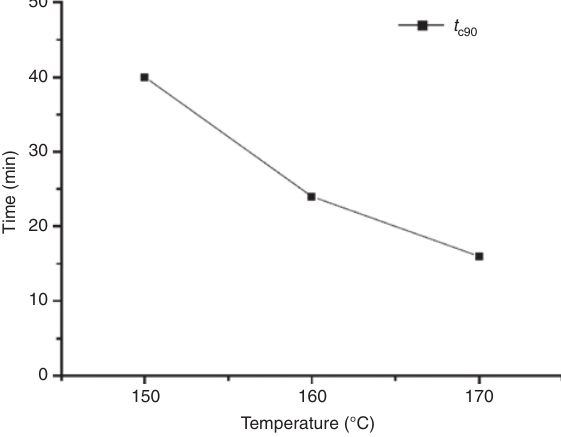
curve of CR with various Figure 3 t c90